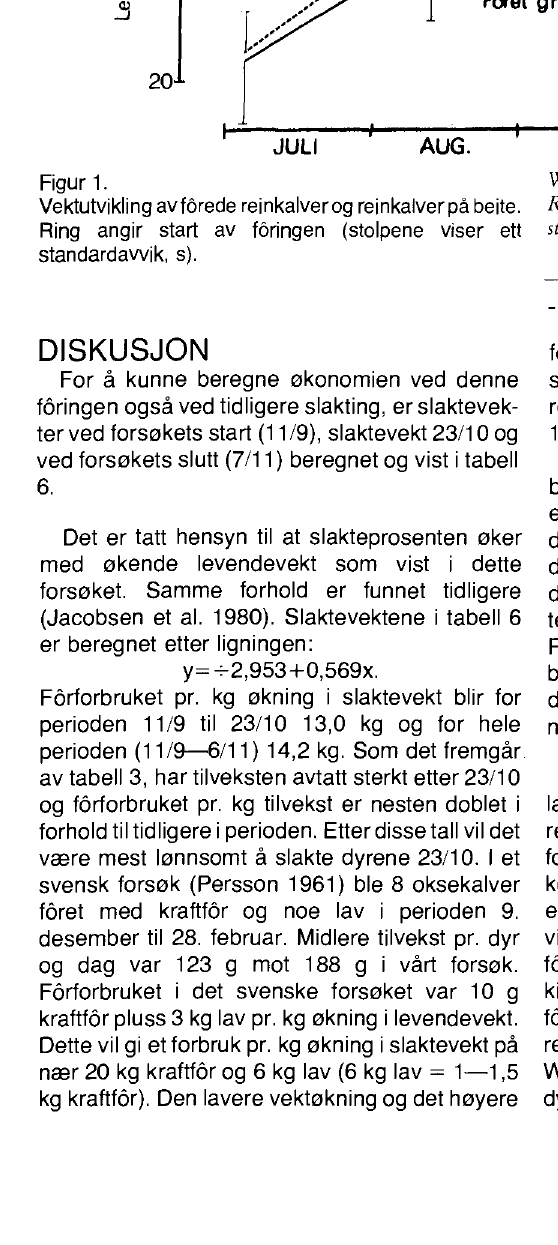
Figur 1. Vektutvikling av forede reinkalver og reinkalver på beite. Ring angir start av foringen (stolpene viser ett standardavvik, s).